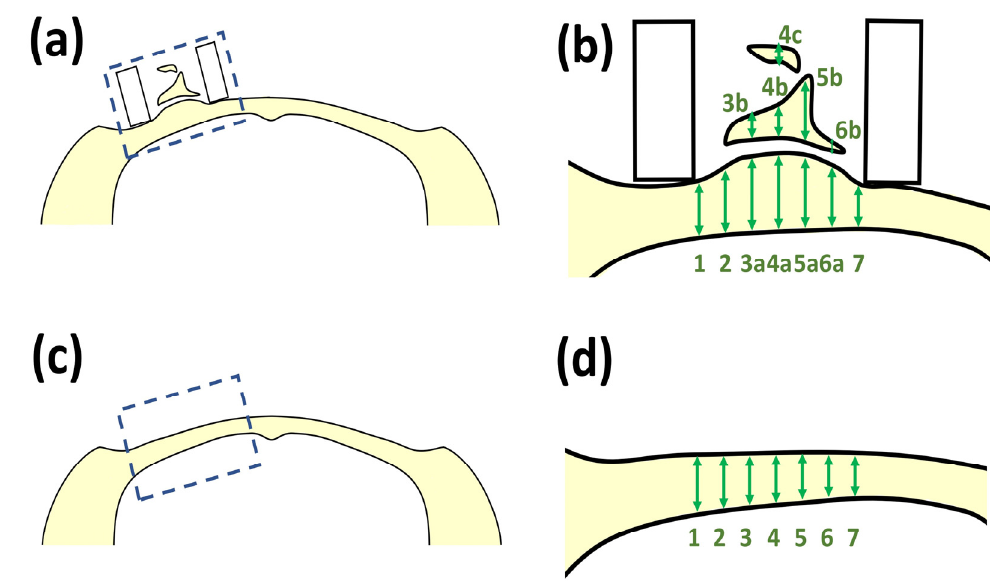
Figure 6. ( a ) Newly formed bone by SG II sample on the left side cranial bone; ( b ) enlarged bone area of the dotted box area in Figure 6a. Note: bone formation activities were scaled by the length of the bone zone on multiple perpendicular lines; ( c ) the sham rat cranial bone; and ( d ) the enlarged bone area of the dotted box area in Figure 6c. Note: Bone thickness was scaled by the length of the bone zone on multiple perpendicular lines.